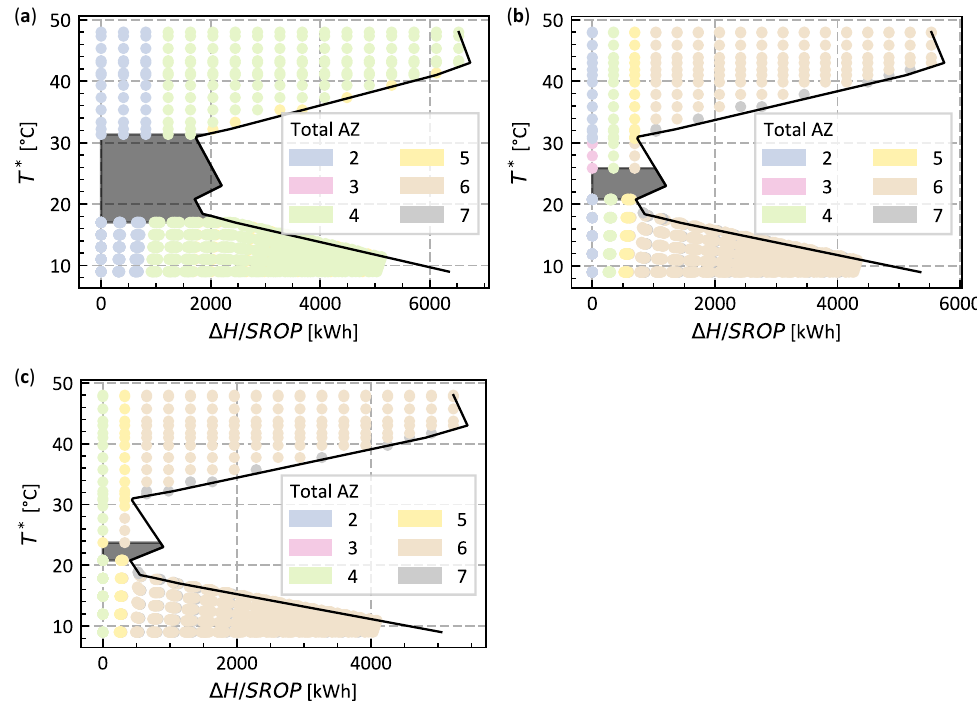
Figure 15. Adapted GCC for the industry case study with IHR of ( a ) 700 kWh, ( b ) 1700 kWh, and ( c ) 2000